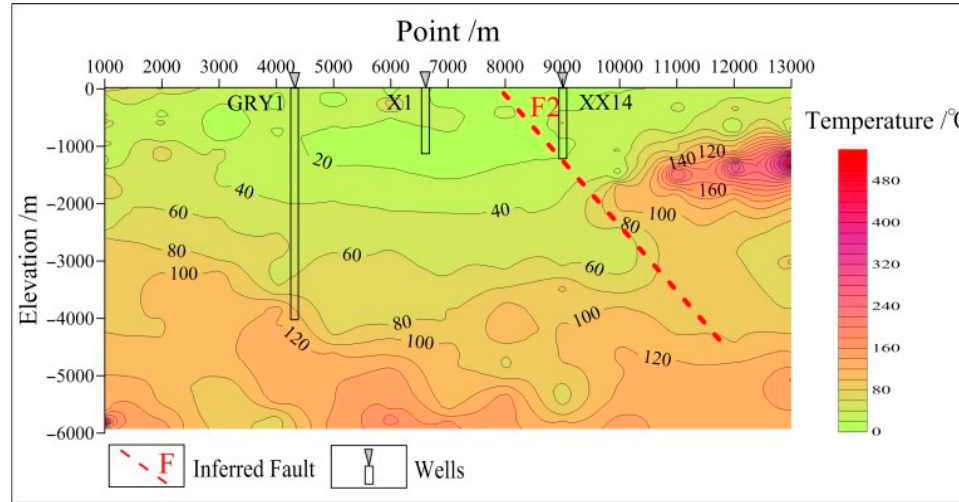
Figure 9. Temperature profile of survey line L2.